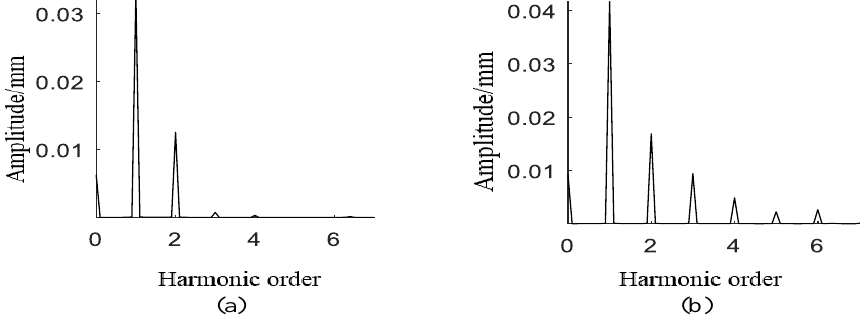
Figure 10. Radial vibration spectrum of generator rotor: ( a ) misalignment 3 mm, short-circuit 1%; ( b ) misalignment 3 mm, short-circuit 10%.